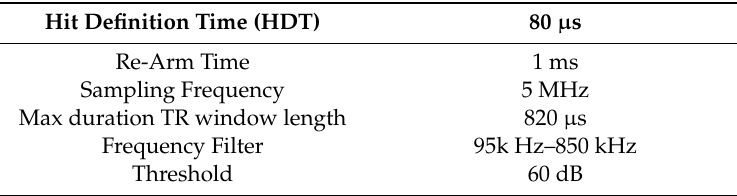
Table 2. Acquisition settings in all the channels.